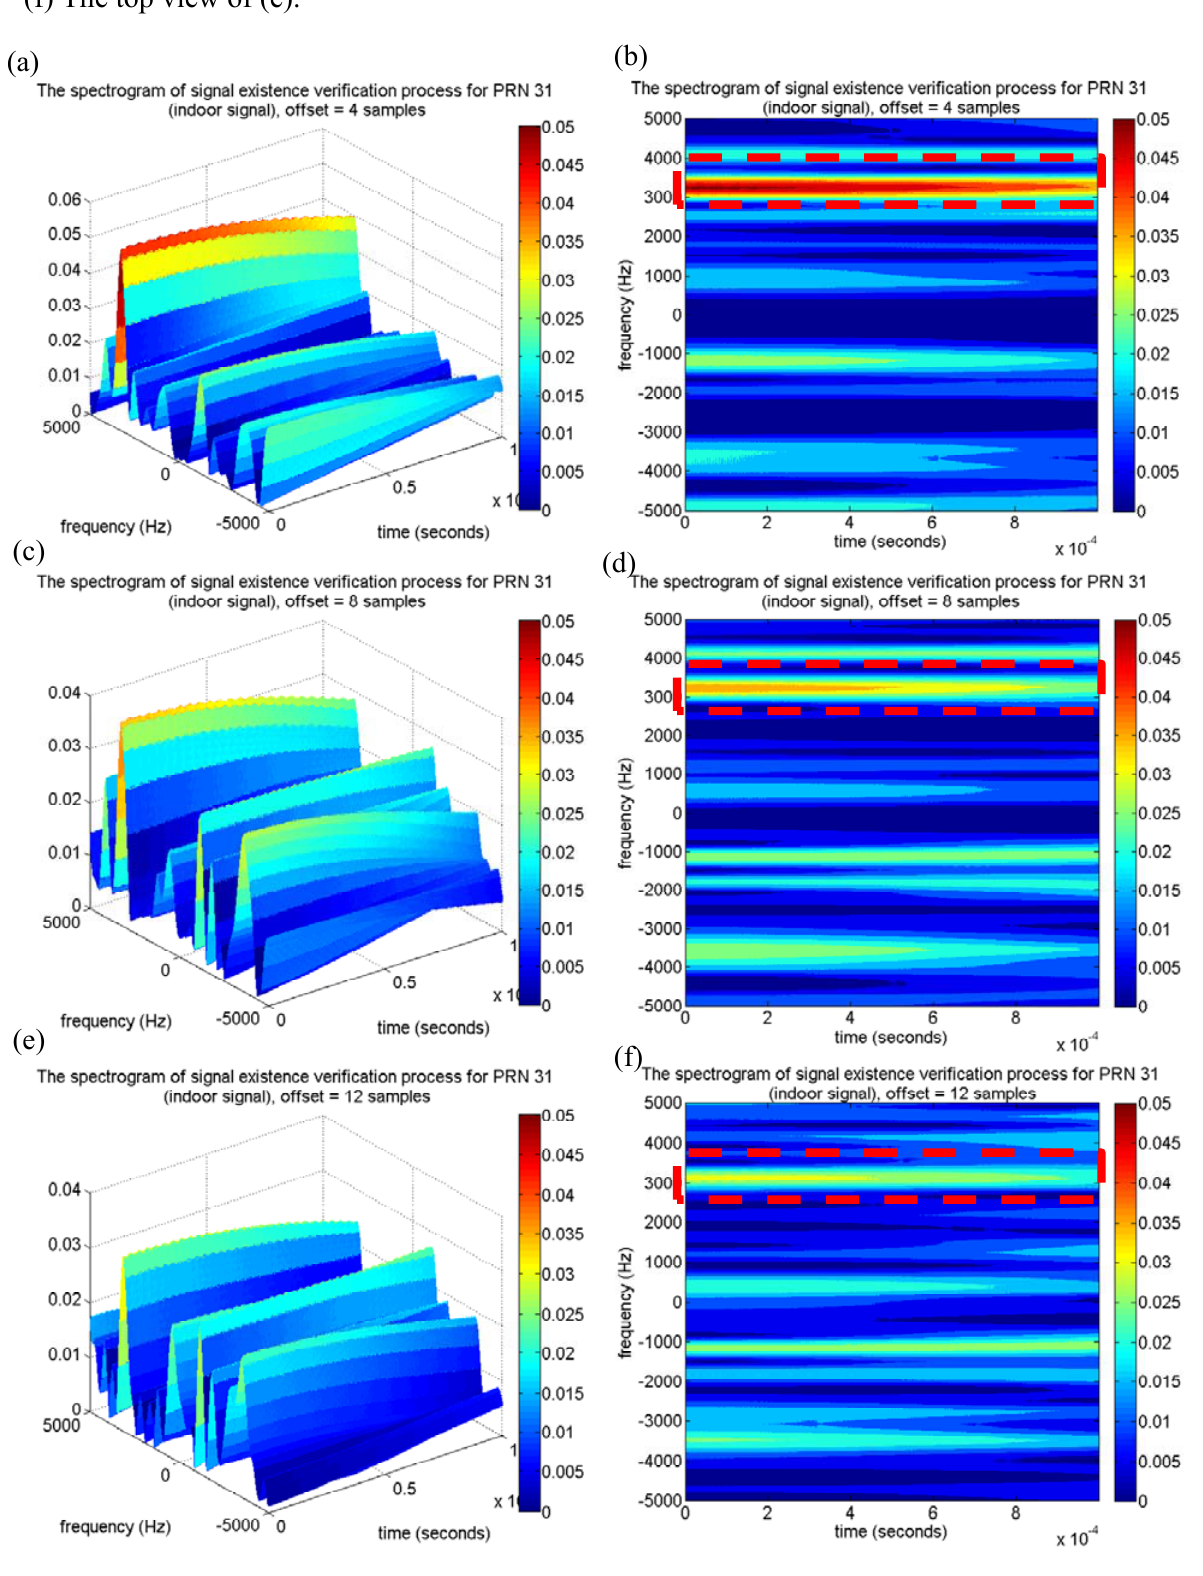
Figure 13. (a) The spectrogram of the proposed approach for PRN 31 satellite signal with miss-alignments of four samples. (b) The top view of (a). (c) The proposed approach for PRN 31 satellite signal with miss-alignments of eight samples. (d) The top view of (c). (e) The proposed approach for PRN 31 satellite signal with miss-alignments of 12 samples. (f) The top view of